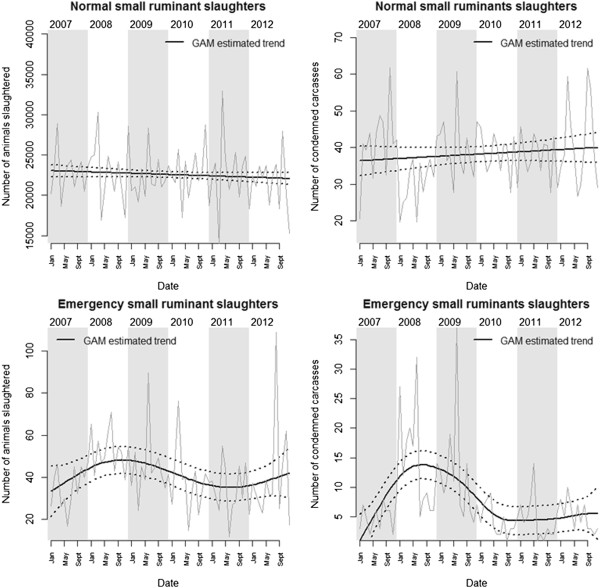
GAM estimated trends for the number of small ruminant carcasses. Monthly numbers of small ruminants slaughtered (left) and condemned carcasses (right) between 2007 and 2012 during normal slaughter (top) and emergency slaughter (bottom) are presented.